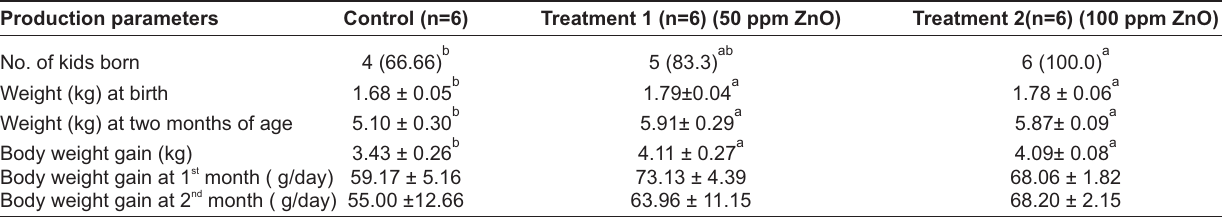
Table-2: Effect of zinc supplementation on the production performance of kids up to two months of age